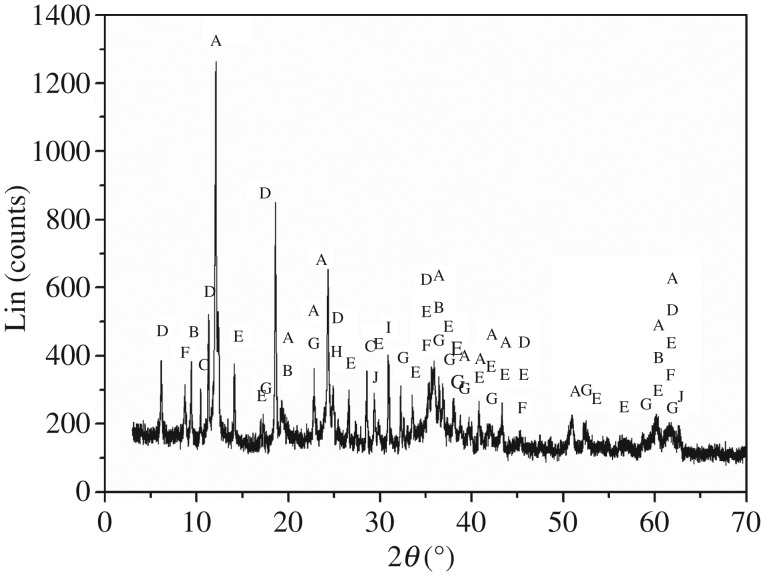
XRD pattern of Kuandian ores. (A) Mg6[Si4O10](OH)8; (B) Mg3[Si4O10](OH)2; (C) Ca2Mg5Si8O22(OH)2; (D) Mg3[Si4O10](OH)2Mg3(OH)6; (E) Mg2(OH)[B2O4(OH)]; (F) KAl2(AlSi3O10)(OH)2; (G) Mg2SiO4; (H) SiO2; (I) CaMg(CO3)2; (J) Fe3O4.